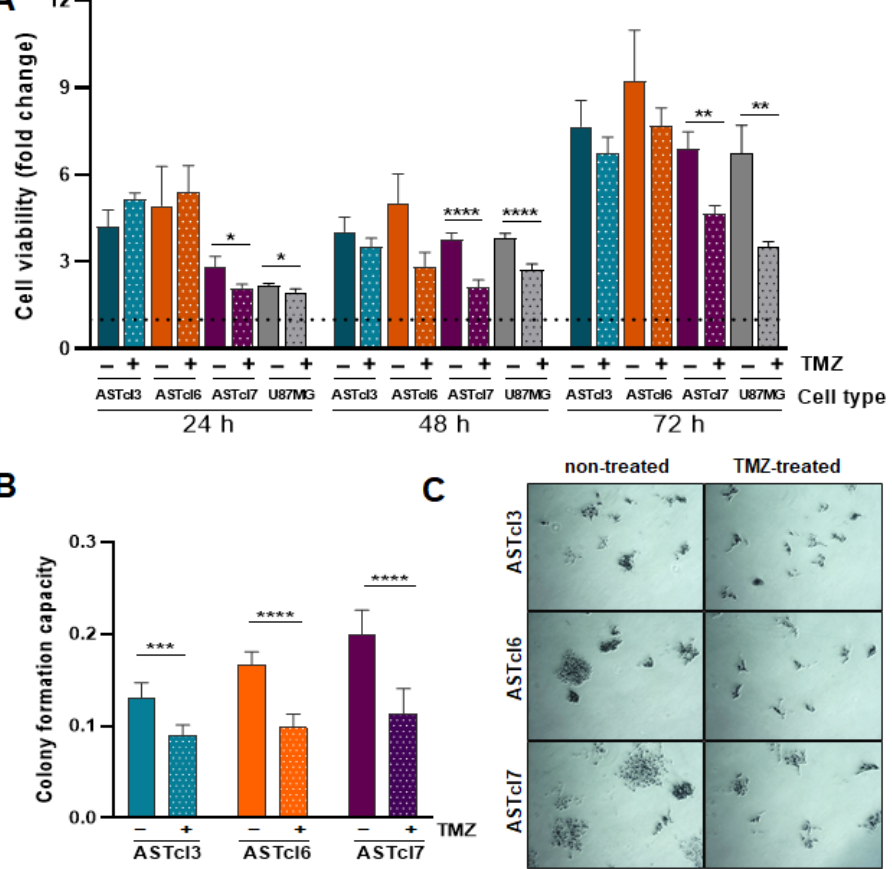
Figure 5. Response of ASTcl3, ASTcl6, and ASTcl7 clones to TMZ treatment: ( A ) Cell viability of ASTcl3, ASTcl6, ASTcl7, and U87MG in the absence ( − ) and presence (+) of temozolomide (TMZ). Bars represent the means ± standard deviations of the fold change relative to the untreated cells at time zero. ( B ) Colony ‐ formation assay of ASTcl3, ASTcl6, and ASTcl7 clones treated after 5 days with 0.72 mM TMZ per 48 h. Bars represent two independent experiments performed in triplicate, and are expressed as the mean ± standard deviation. ( C ) Representative photomicrographs of col ‐ ony ‐ formation assays. Statistically significant differences are represented by asterisks: * p < 0.05, ** p < 0.01, *** p < 0.001, and **** p < 0.0001.